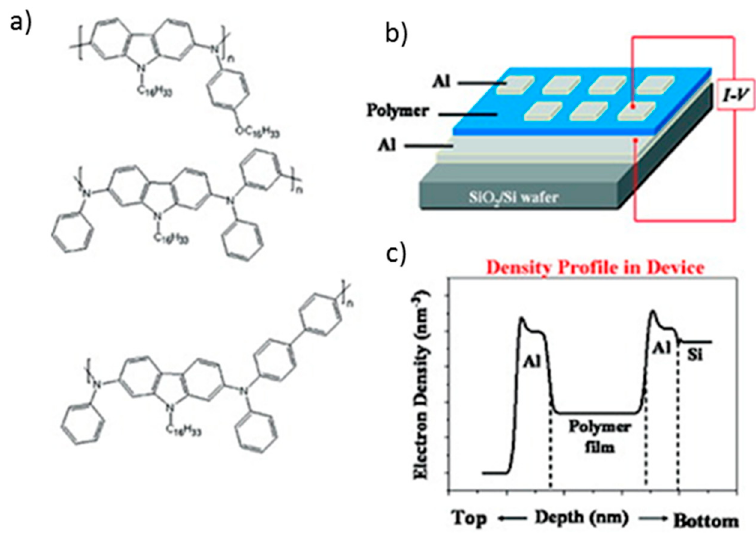
Figure 23. ( a ) Structure of poly(2,7-carbazole) derivate polymers obtained by Hahm et al.; ( b ) Scheme diagram of the memory devices fabricated and ( c ) obtained electron density profiles. Reproduced with permission from [187]. Copyright (2011) American Chemical